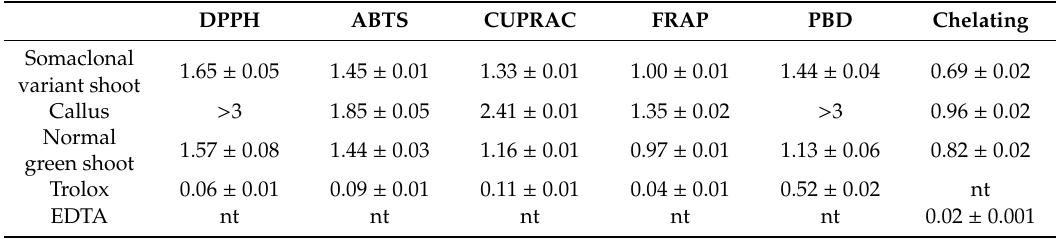
Table 12. Antioxidant parameters of the tested extracts (IC50 (mg / mL)).